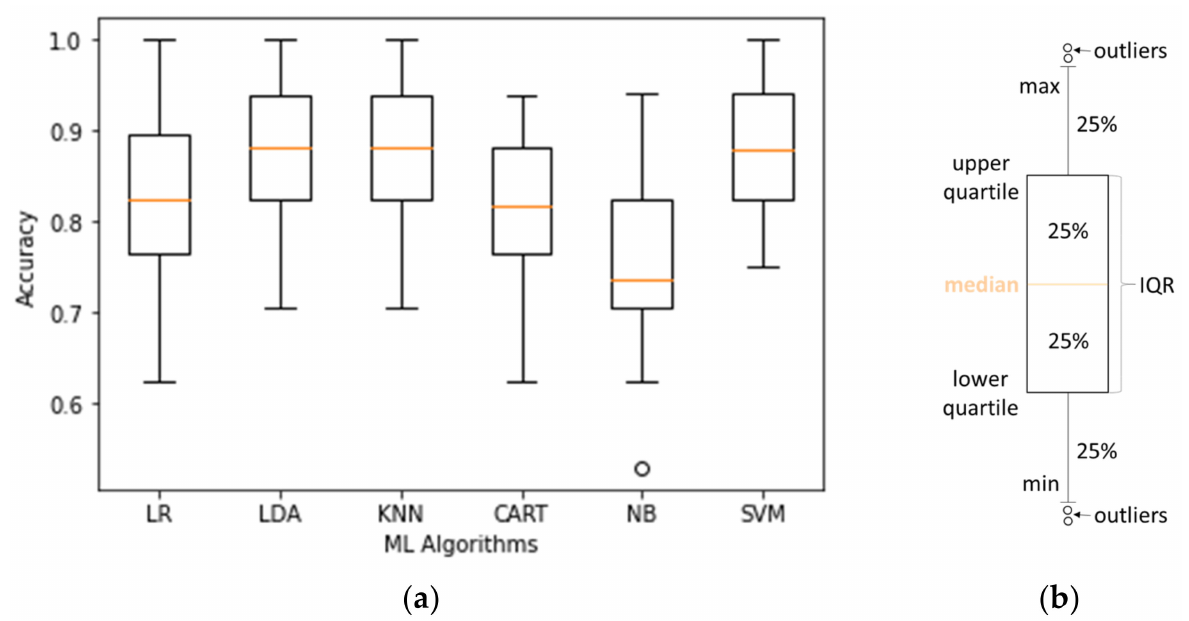
Figure 7. ( a ) Box plot distribution of the accuracy of the examined machine learning algorithms; ( b ) illustration of the main set of data in a typical box